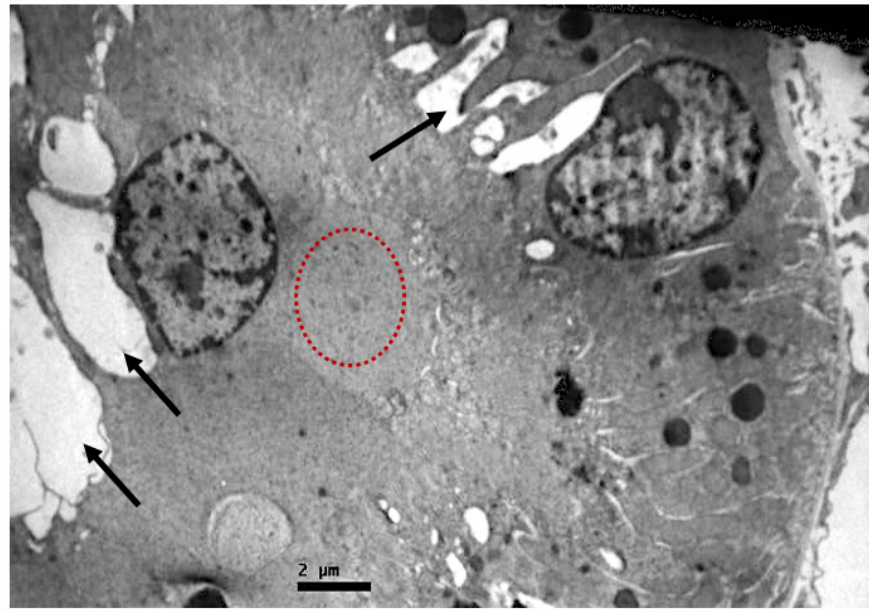
Figure 7. Proximal convoluted tubule epithelium of resuscitated swine sample. Cellular material is observed inside the lumen of the tubule (red dotted circle). Vacuoles (black arrows).